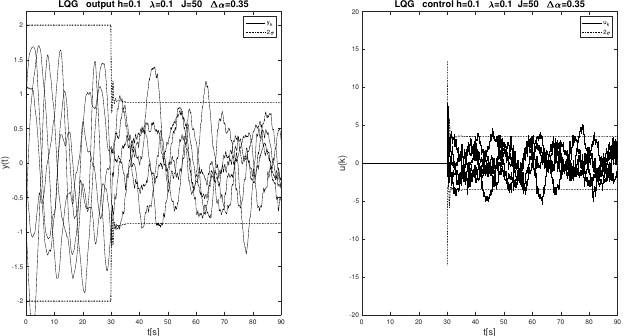
Figure 6. Realization of the output ( left ) and control ( right ) signal for λ = 0.1 and ∆ α = 0.35.